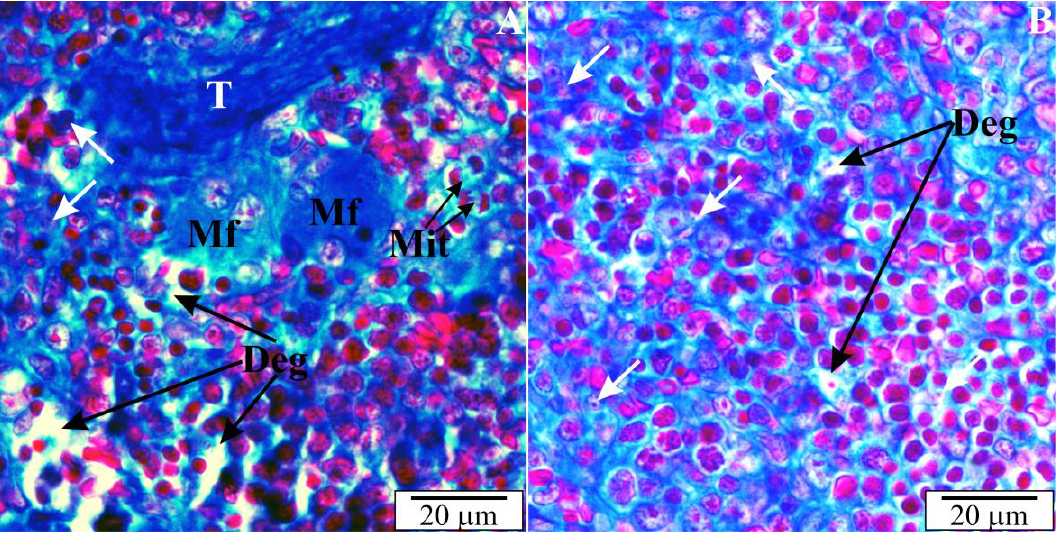
Figure 10. ( A , B ) Spleen of a rat with transplacental infection with B. microti 3 weeks after birth. Deg—fissured parenchymal dissections (degenerative changes), T—trabeculae, Mf—macrophages, Mit—cells during karyokinesis, white arrows— B. microti inclusions.